Question: From the figure, is the trend upward or downward?
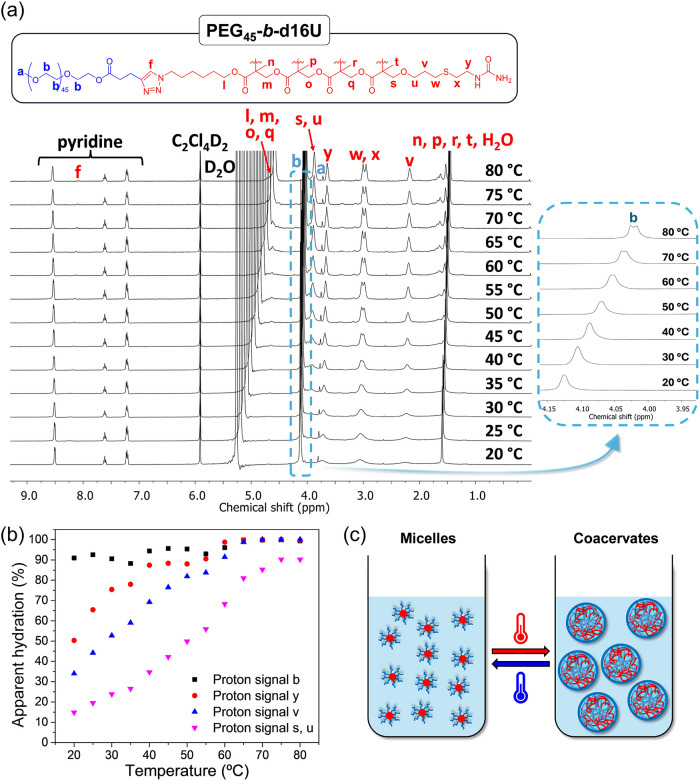
Answer: increasing